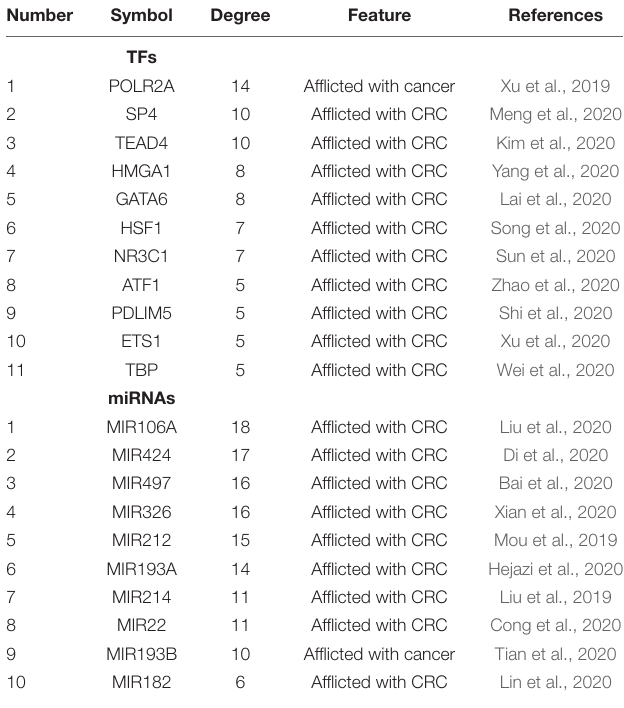
TABLE 1 | Summary of top 10 regulatory biomolecules (TFs and miRNAs) of the five hub genes in CRC identified from TFs-miRNAs-hub genes